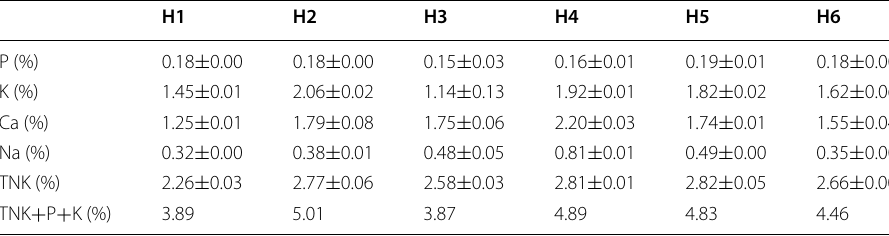
Table 2 Mineral content (%) of the six final